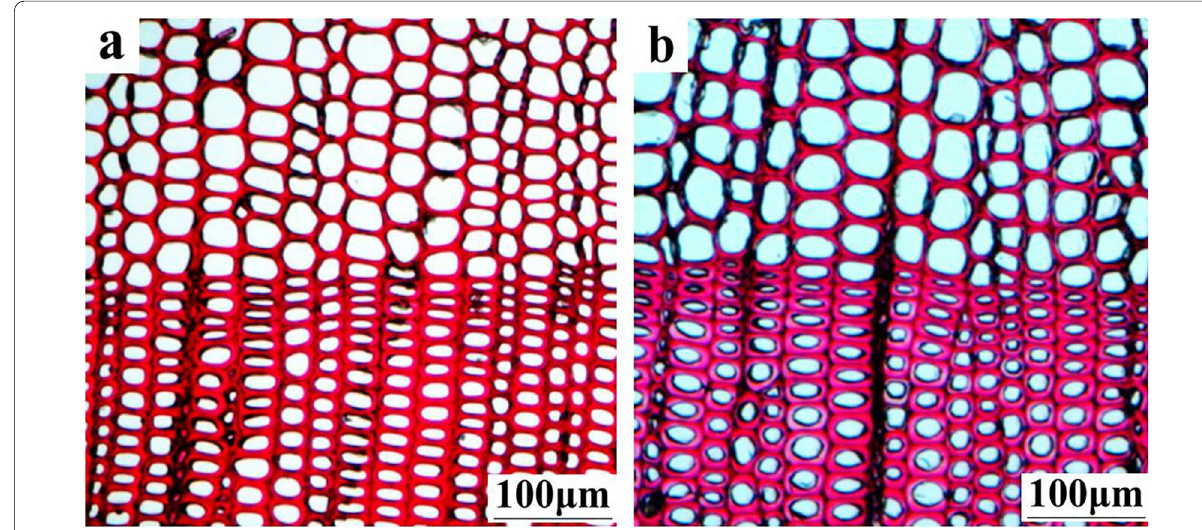
Fig. 2 The cross‑sectional microstructures of the Pinus radiata corewood and outerwood (a corewood, b outerwood)